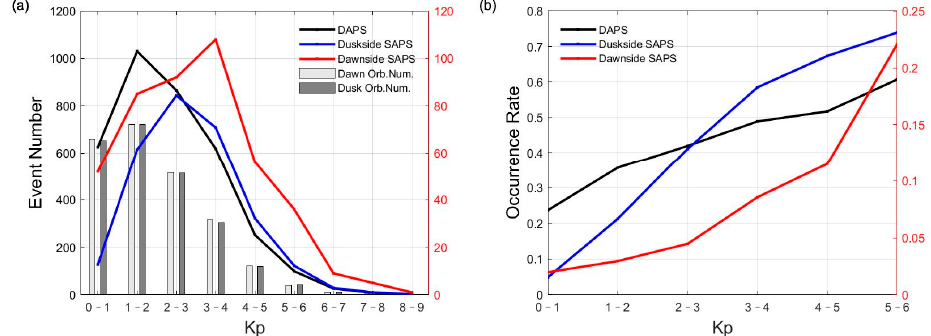
Figure 6. The event numbers ( a ) and occurrence frequencies ( b ) of the SAPS and DAPS as a function of Kp. The black curve is for the DAPS, the blue curve is for the duskside SAPS, and the red curve is for the dawnside SAPS. For DAPS and the duskside SAPS, the scale in the left axis is used, while for the dawnside SAPS, the scale in the right axis is used. The F16 orbit numbers divided by a factor of 4 for better visualization in the dawn and dusk sectors are shown as bars (the scale in the left axis is used).